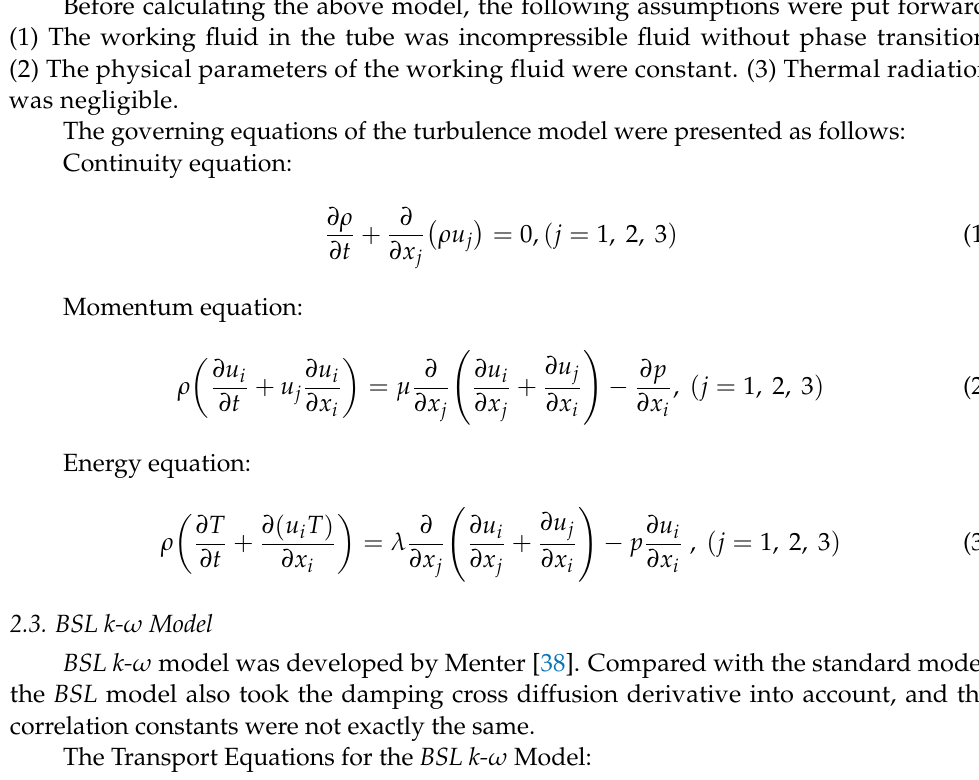
Figure 1. Detail view of the circular tube inserted with RWVGs and the locations of three cross-sections. Table 1. Geometrical structures and parameters used during numerical studies.